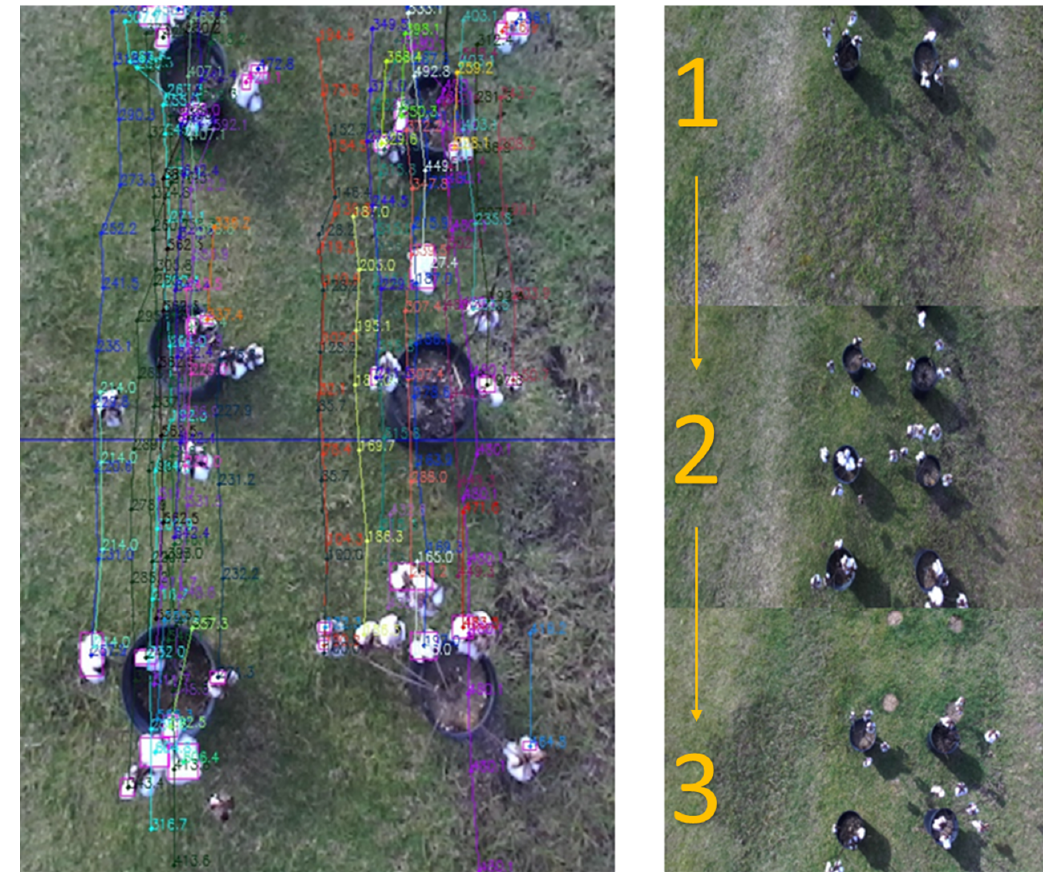
Figure 10. Left image shows processed boll position and tracking of the boll while the right images show a series of 3 image frames acquired from the moving camera.